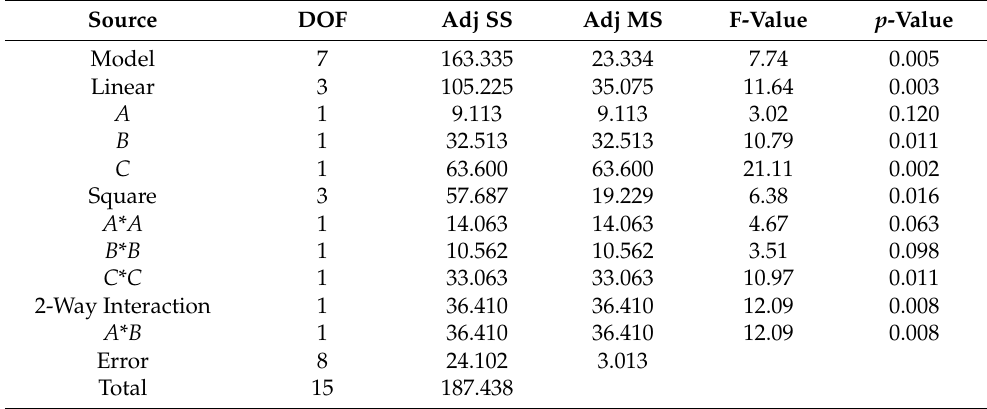
Table 11. ANOVA analysis for SR obtained using MFO algorithm.